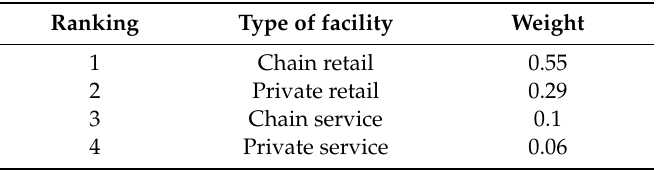
Table 4. Weight of facility